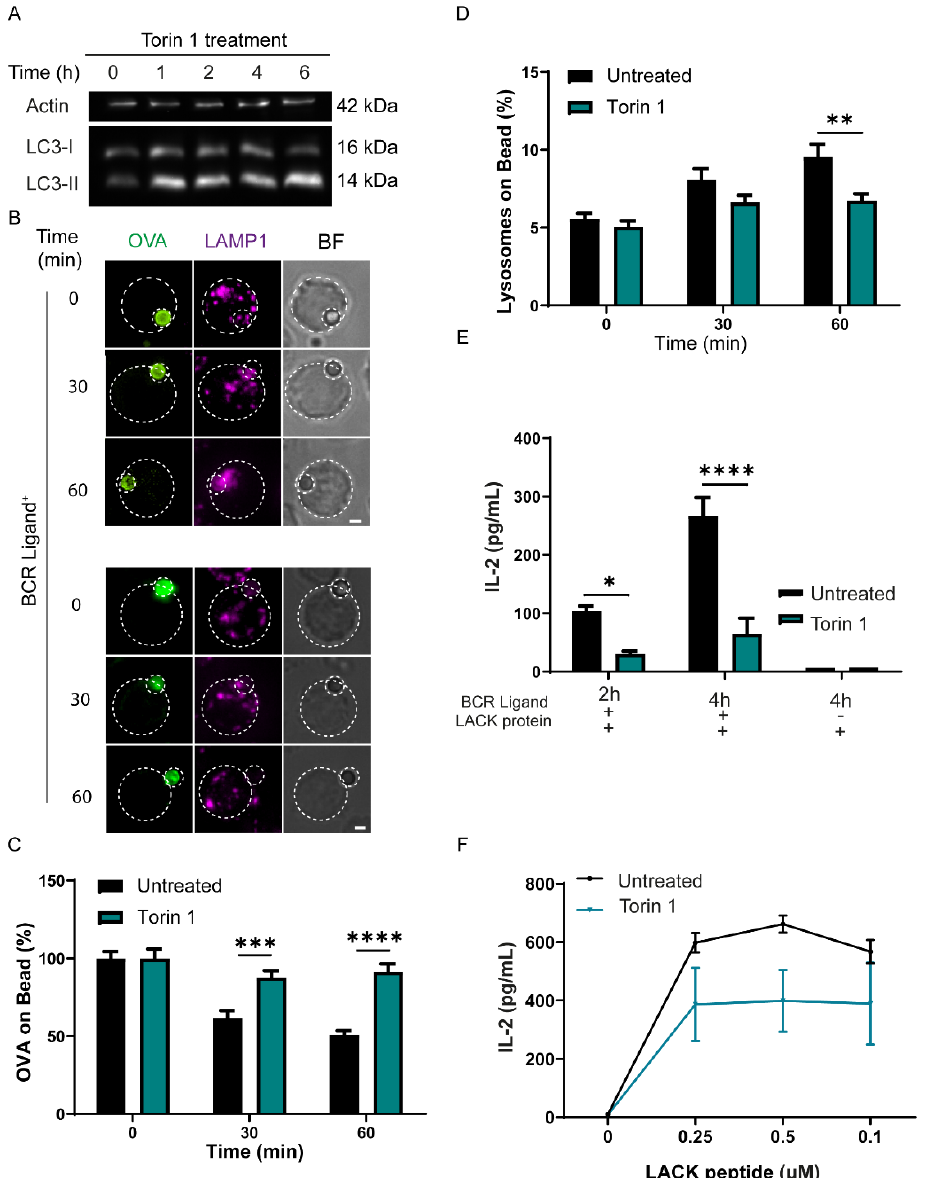
Figure 4. Induction of autophagy, independently of TLR stimulation, decreases antigen extraction and presentation by B cells. ( A ) immunoblot showing levels of LC3-II in B cells treated with Torin 1 at different time points; a representative blot of 3 independent experiments is shown. ( B ) Representative images of control and Torin 1-treated B cells incubated with beads coated with OVA and BCR ligand+ (anti-IgG) for different periods of time. Cells were fixed and stained for OVA (green) and LAMP-1 (magenta). Images are shown as Z-projections of a stack. Scale bar = 3 µm. N = 3. ( C ) Quantification of OVA fluorescence remaining on the bead, normalized by initial fluorescence. *** p < 0.001, **** p < 0.0001. N = 3. (>55 cells). Two-way ANOVA with Sidak’s multiple comparison test. ( D ) Quantification of lysosome accumulation at the IS. ** p < 0.01. N = 3. (>55 cells). Two-way ANOVA with Sidak’s multiple comparison test. ( E ) Antigen presentation assay of control or Torin 1-treated B cells. Levels of IL-2 secretion by T cells were quantified by ELISA * p < 0.05, **** p < 0.0001. N = 3. ( F ) Representative graph of peptide controls for cells used in antigen presentation assays. N = 3.